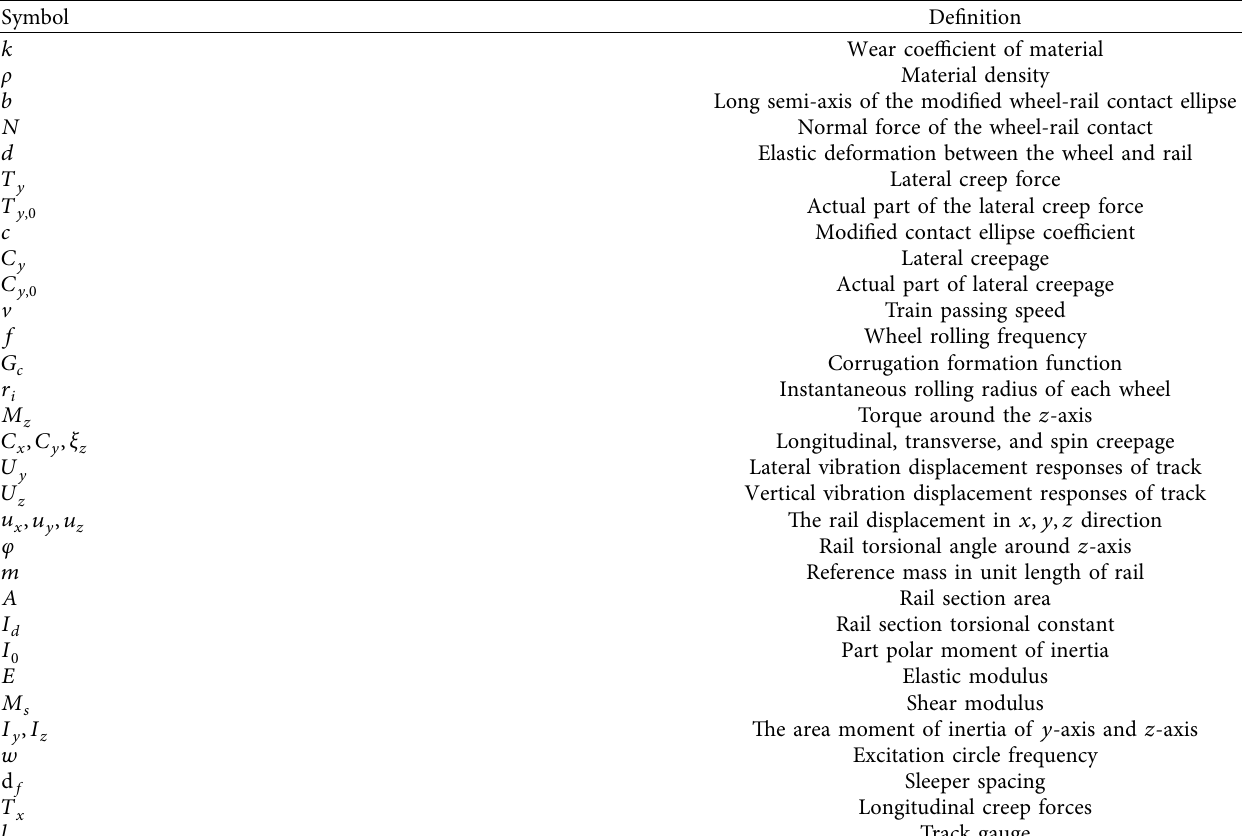
Table 1: Symbols used in